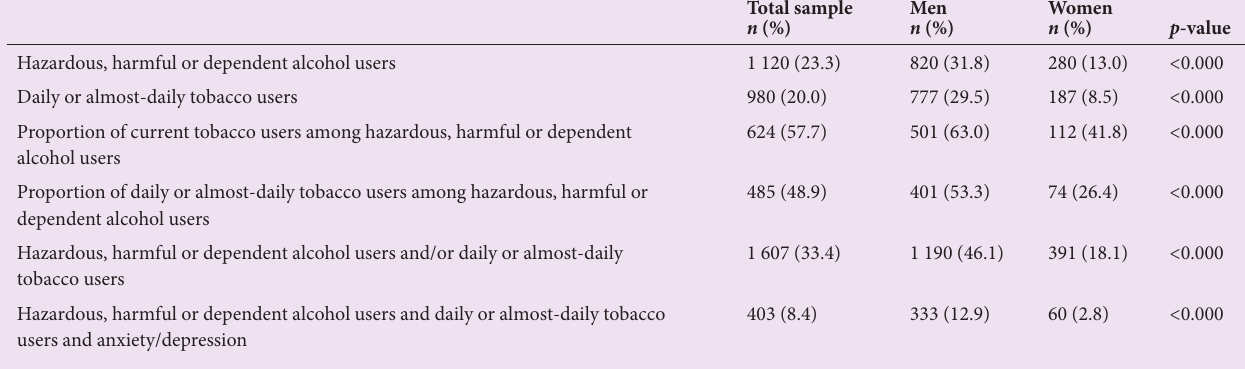
Table 2. Alcohol use disorder, nicotine dependence, anxiety/depression and